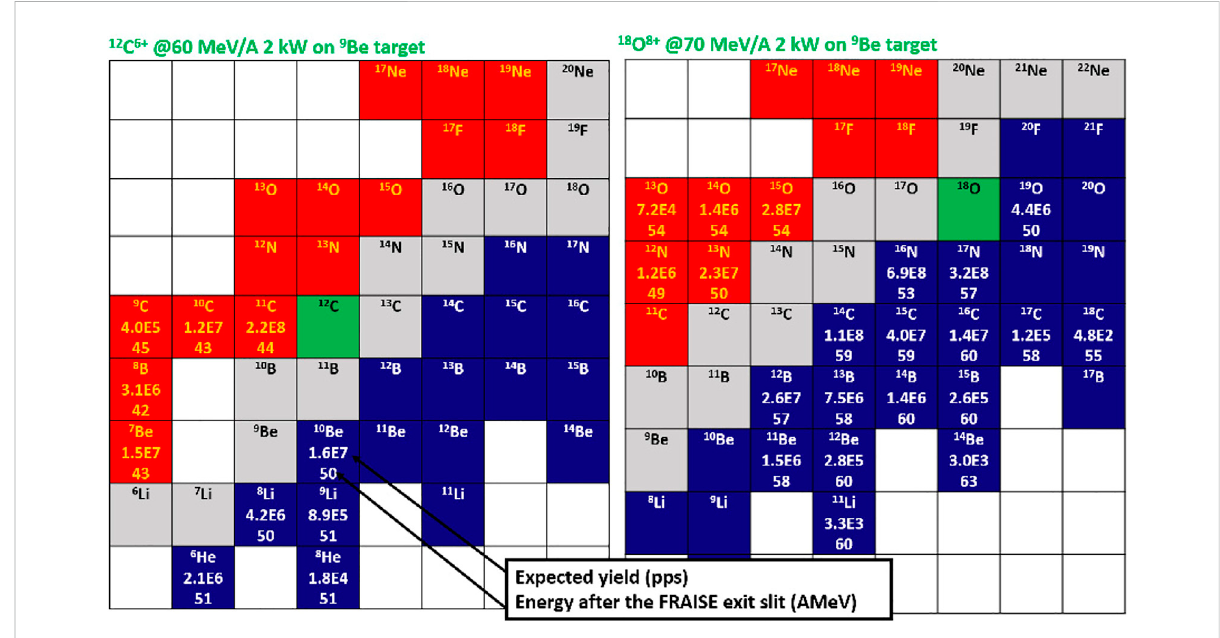
FIGURE 7 Left: simulation of RIBs that can be produced with FRAISE, using 12 C as the primary beam. Right: same as left, using 18 O as primary beam. The fi gure is taken from [34].